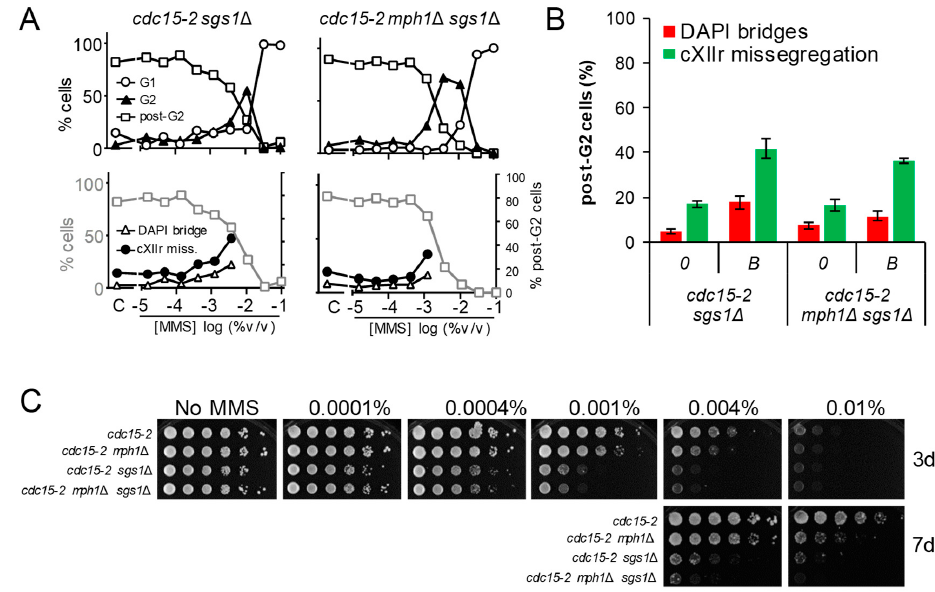
Figure 5. The combination of mph1 Δ and the knockout for the 3 ′ → 5 ′ helicase Sgs1 renders neutral genetic interactions with respect to the G2 block and post ‐ G2 figures. ( A ) MMS dose ‐ response curves of the FM588 sgs1 Δ and sgs1 Δ mph1 Δ mutant derivatives. ( B ) DAPI ‐ bridges and cXIIr missegregation of three independent experiments without (“0”) or with borderline (“ B ”) MMS (mean ± SEM). B was 0.004% v/v for sgs1 Δ and 0.001% v/v for sgs1 Δ mph1 Δ . ( C ) Long ‐ term survival (spotting assay) for the referred mutants under increasing doses of MMS. Note that, relative to sgs1 Δ , mph1 Δ was (i) epistatic for the G2 block, (ii) hypostatic for cXIIr missegregation and (iii) synthetic (negative synergism) for long ‐ term fitness at high, but not low, MMS concentrations.